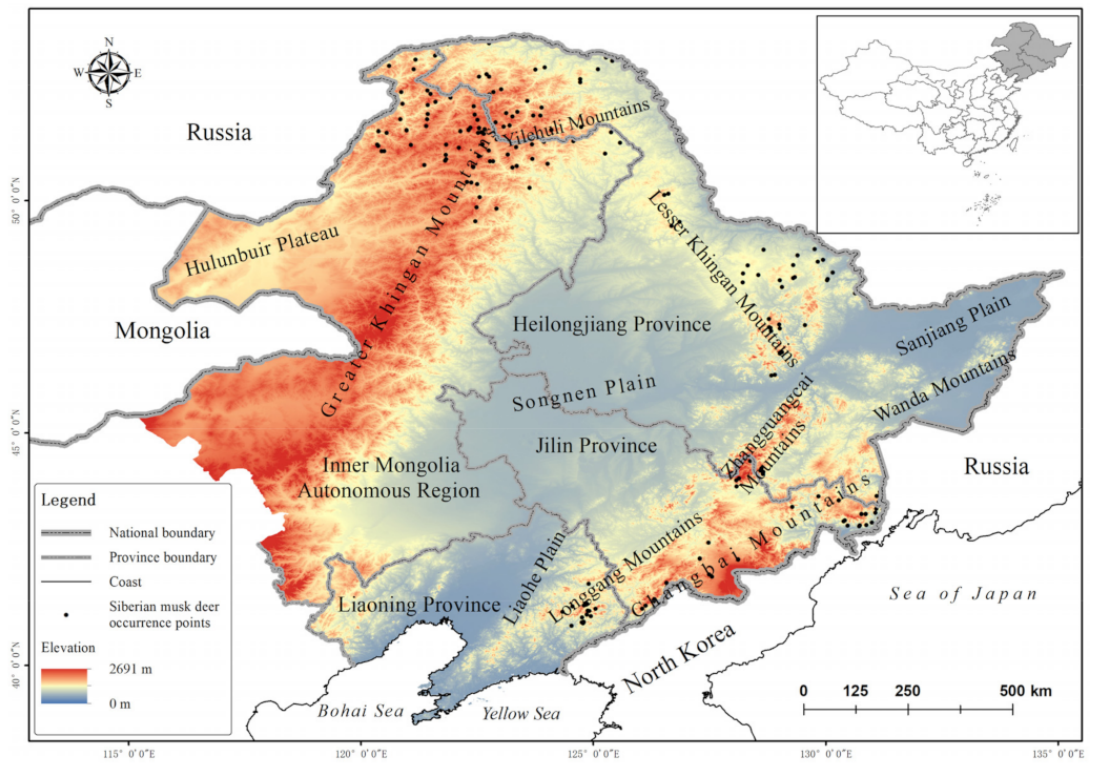
Figure 1. Occurrence points of Siberian musk deer ( Moschus moschiferus ) in Northeast